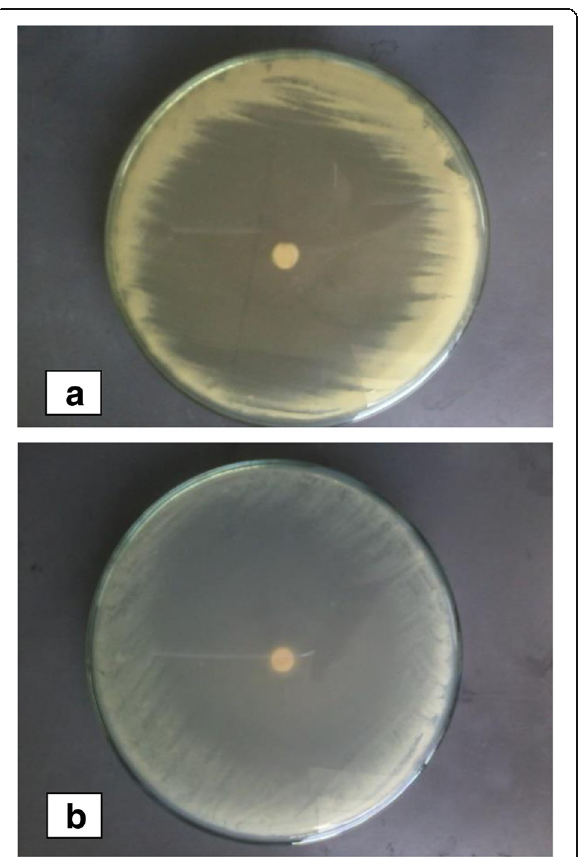
Fig. 4 Zone of inhibition produced by miswak extract in Petroleum ether alone and in combination with ethanol against both test organisms. a PM extract against c. albicans , b PM+EM extract combination against S.